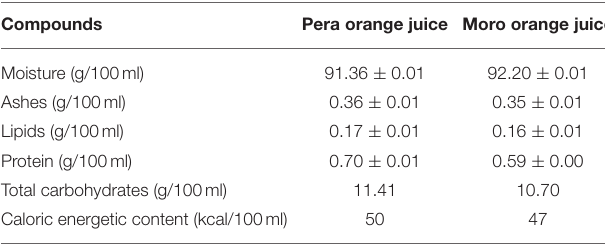
TABLE 2 | Orange juices macronutrients compounds.